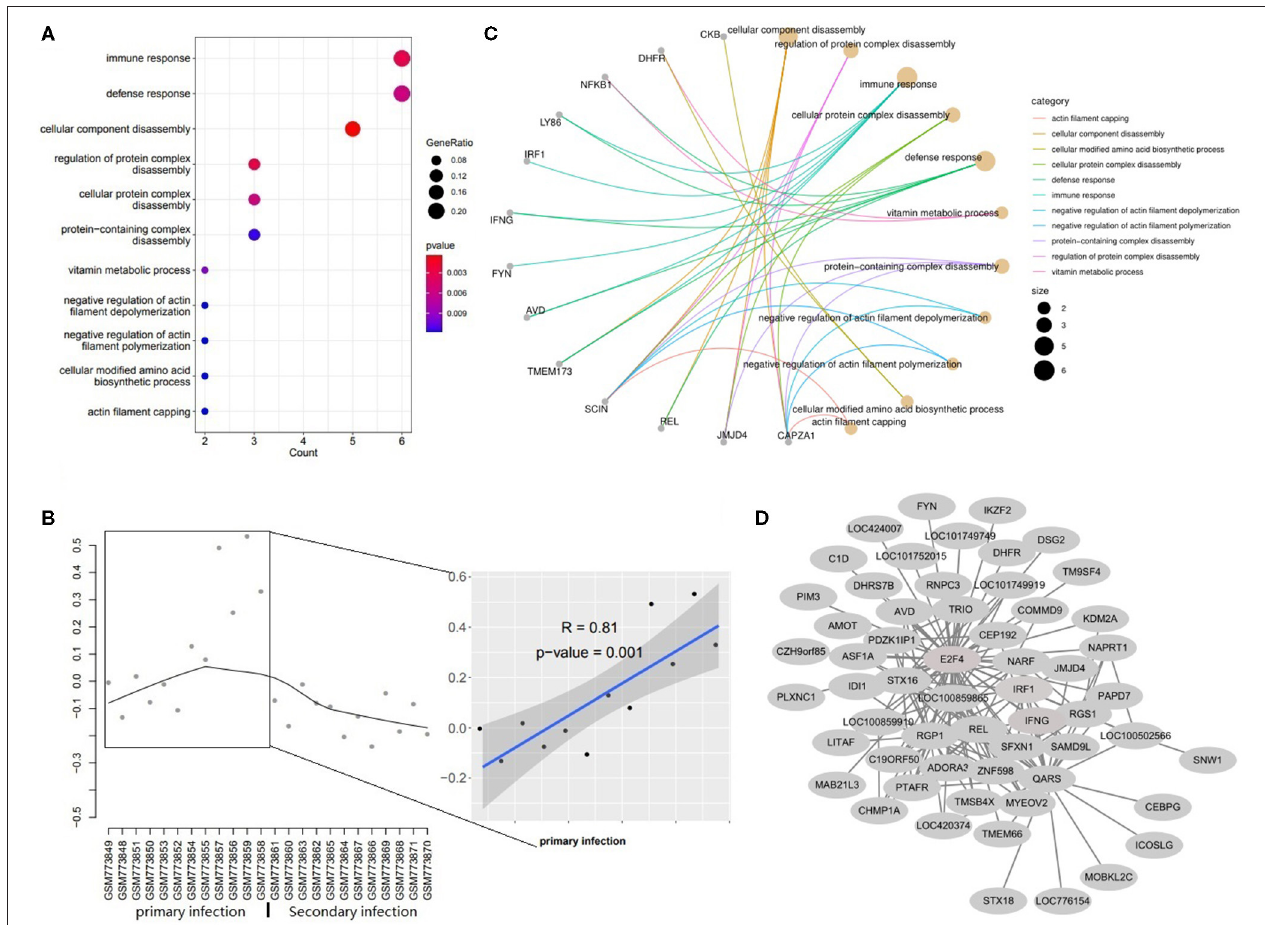
FIGURE 4 | The Functions for genes in magenta module. (A) The dotplot of top 11 BPs. (B) The concept network of top 11 BPs. (C) The trajectory curve and linear regression for the eigengene. (D) The coexpression network for module